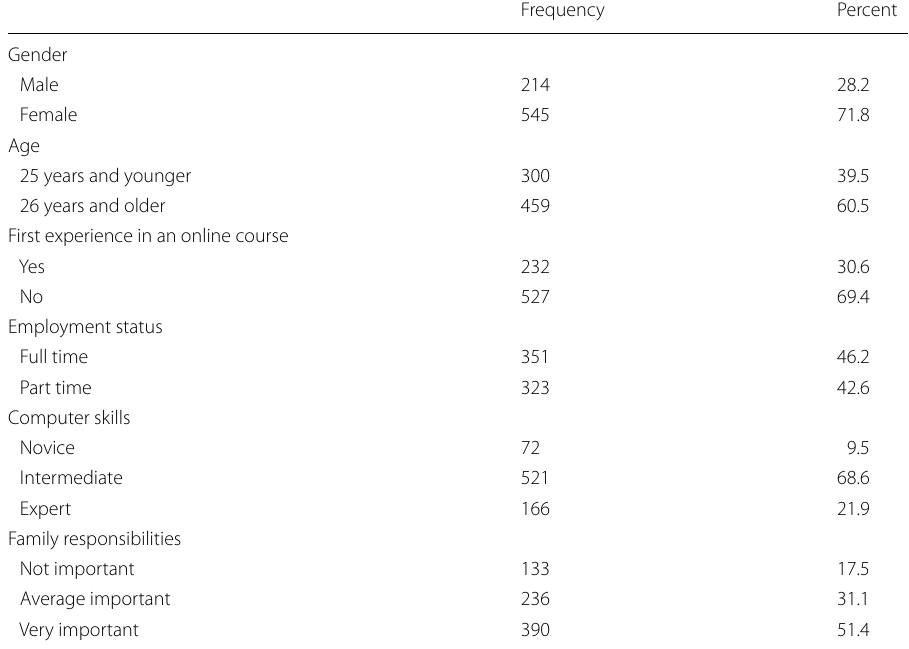
Table 2 The profile of participants